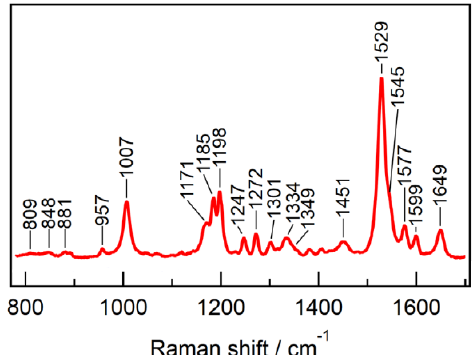
Figure 13. RR spectra of HeR 48C12 obtained using a 532 nm probe laser for 60 min accumulation. The emission background and the spectral component of the buffer were subtracted in the spectra. Reprinted from [317] with permission from ACS Publications.